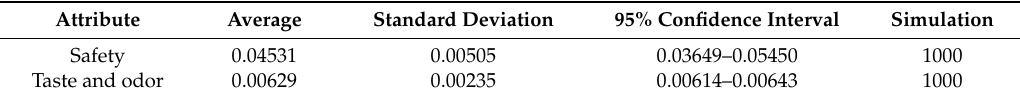
Table A3. Confidence interval of the median WTPs of ANA 1 model.